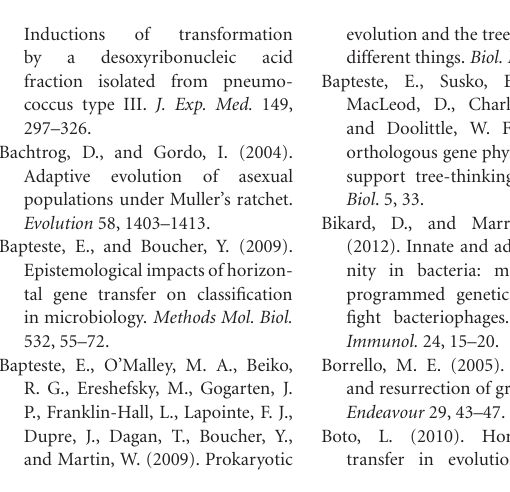
multiple, new and interconnected layers of complexity ( Figure 8 ) such that the conceptual core is but a small part of the current big picture of evolutionary